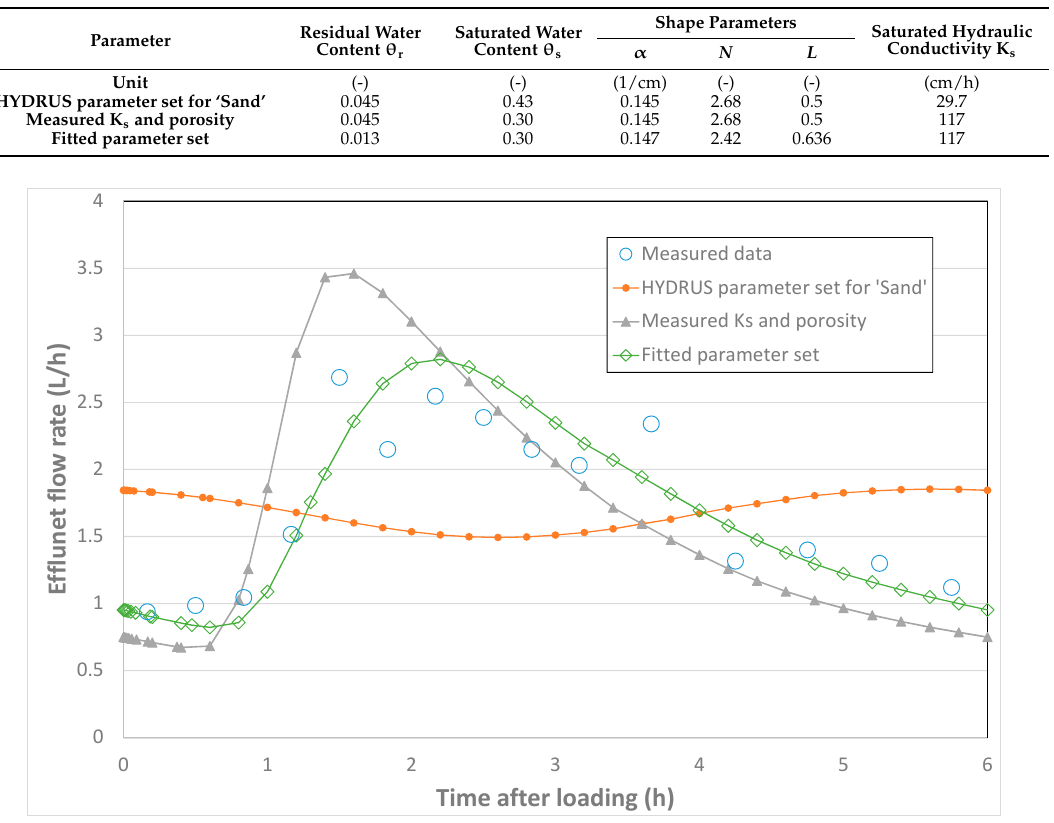
Figure 2. Measured and simulated effluent flow rates of the VF pilot ‐ scale wetland for a single loading of 10 L (“ HYDRUS parameter set or ‘ Sand ’”, “ Measured Ks and porosity ” and “ Fitted parameter set ” represent the parameter sets from Table 3).